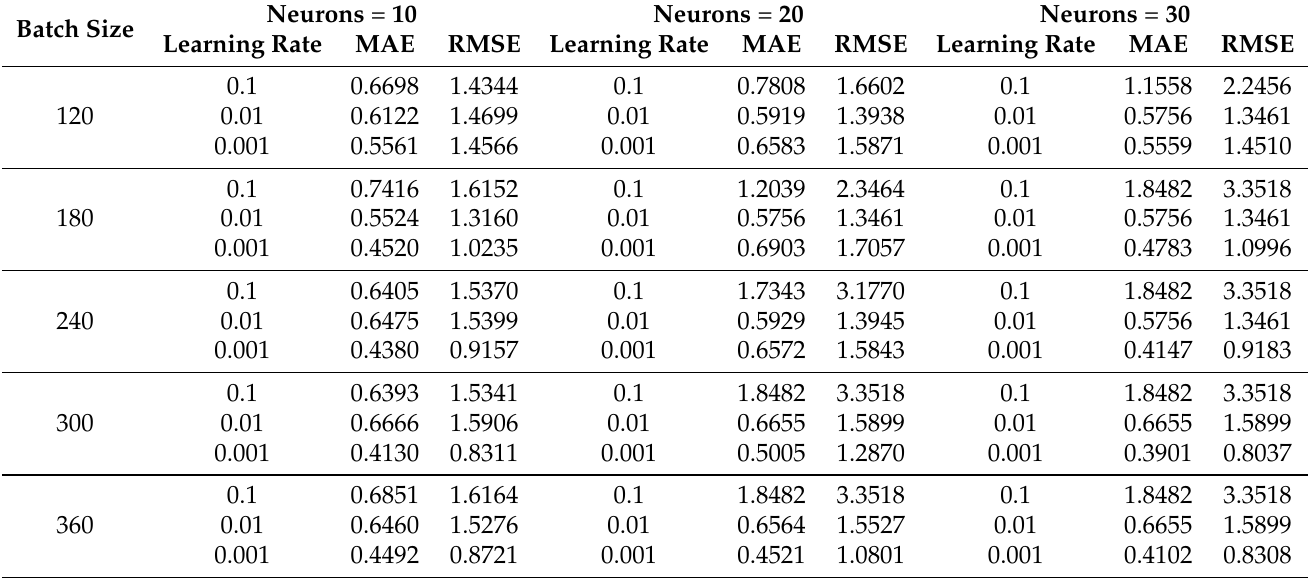
Table 2. The optimization process of parameters.